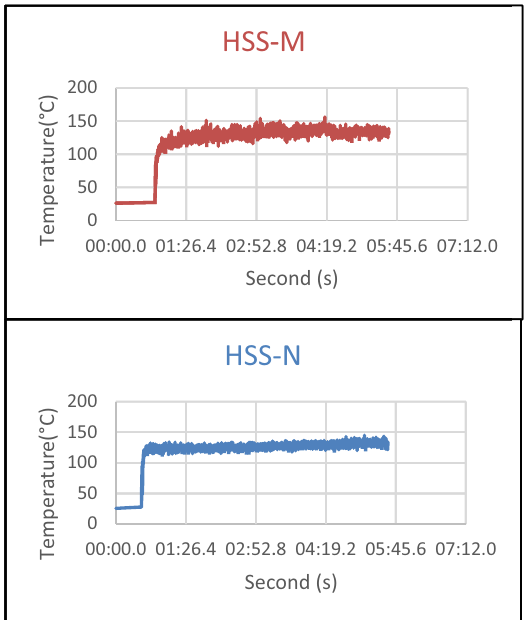
Figure 9: Temperature measurements during process.